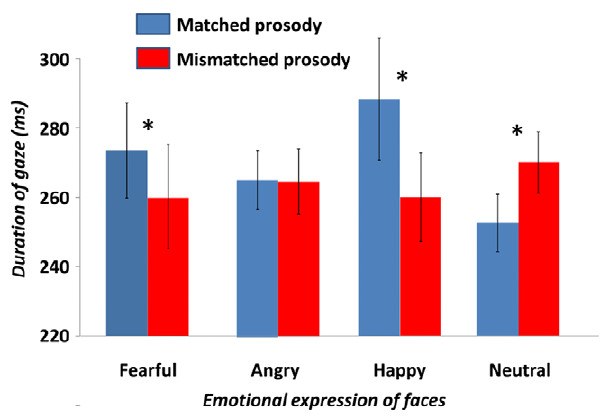
Figure 2. Mean duration of first fixations as a function of facial expression type and the matching status of the prosody (error bars refer to SEM ; *: p , 0.05).